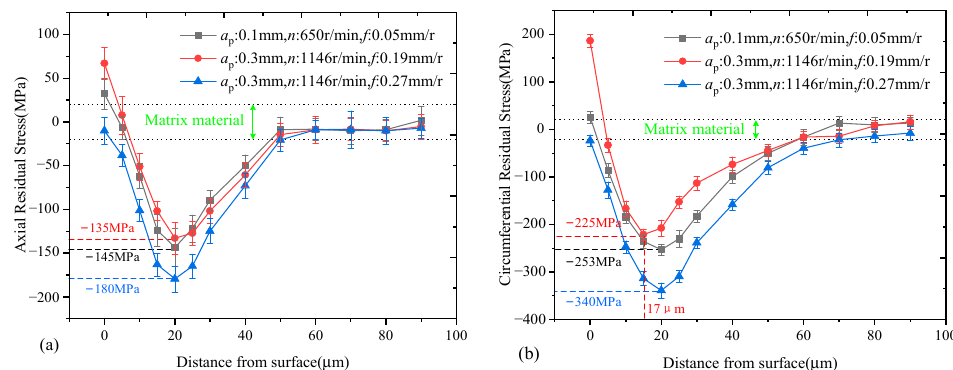
Figure 5. Residual stress distribution of the specimens machined by different processing parameters: ( a ) axial residual stress distribution and ( b ) circumferential residual stress distribution.